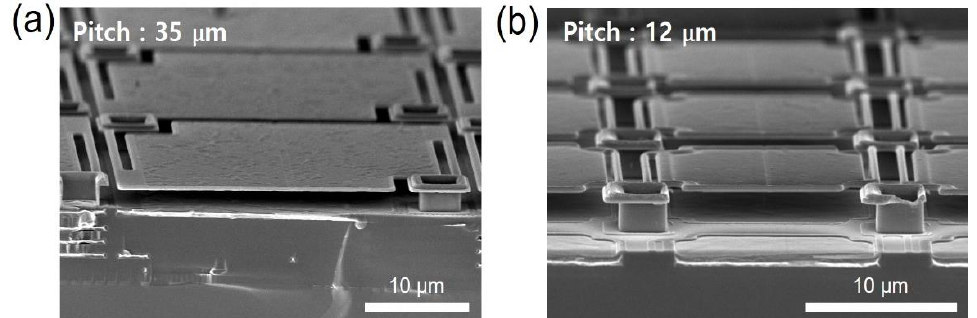
12 μm are shown in Figure 3a ,b, respectively.